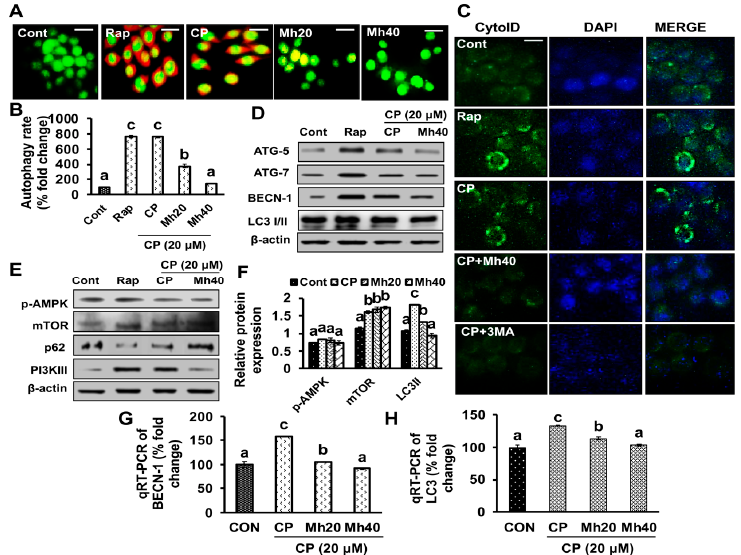
Figure 6. Effect of CP and CP-Mh on autophagy induction in HepG2 cells. ( A ) AO stained images of HepG2 cells taken after corresponding drug treatment by fluorescence microscopy; autophagosomes are visualized as red fluorescence (scale bar 0.1 mm). ( B ) Autophagy rate calculated manually using ImageJ software ( C ) Fluorescence images of HepG2 showing autophagic vesicles stained with Cyto-ID ® green visualized by fluorescence microscope. ( D ) Western blot analysis performed using specific antibodies for Atg5, Atg7, Beclin-1 and LC3I / II ( E ) Western blot analysis of p-AMPK, mTOR, p62 and PI3KIII after CP, CP-Mh and Rap treatment. ( F ) Relative expression of p-AMPK, mTOR and LC3I / II analyzed by densitometry analysis by ImageJ software. ( G ) Quantitation of BECN-1 mRNA level and ( H ) LC3 mRNA level by qRT-PCR after corresponding drug treatment in HepG2 cells. The data are represented as the means standard deviation ( ± SD, n = 3). The values of di ff erent letters (a–d) di ff er significantly from each other ( p <